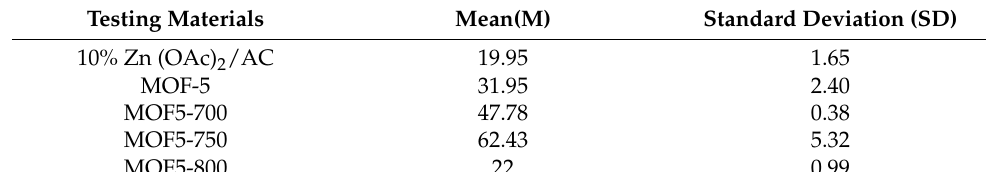
Table 2. Means (M) (n = 10) and standard deviations (SD) of the five sets of catalyst variables.